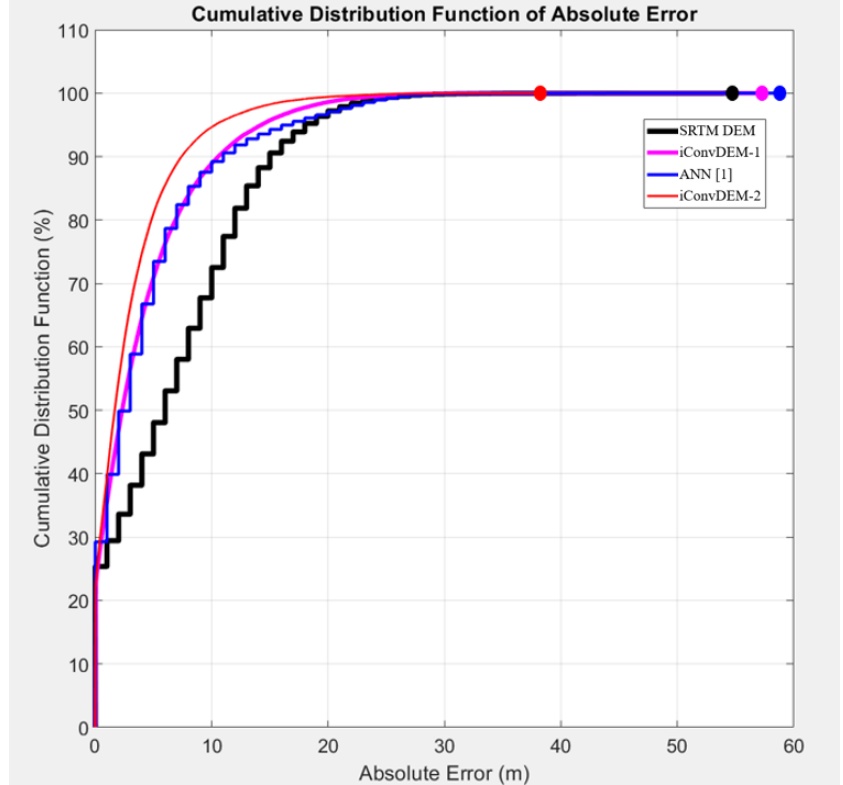
Figure 8. Cumulative distribution of absolute error values of all approaches versus reference DEM data.